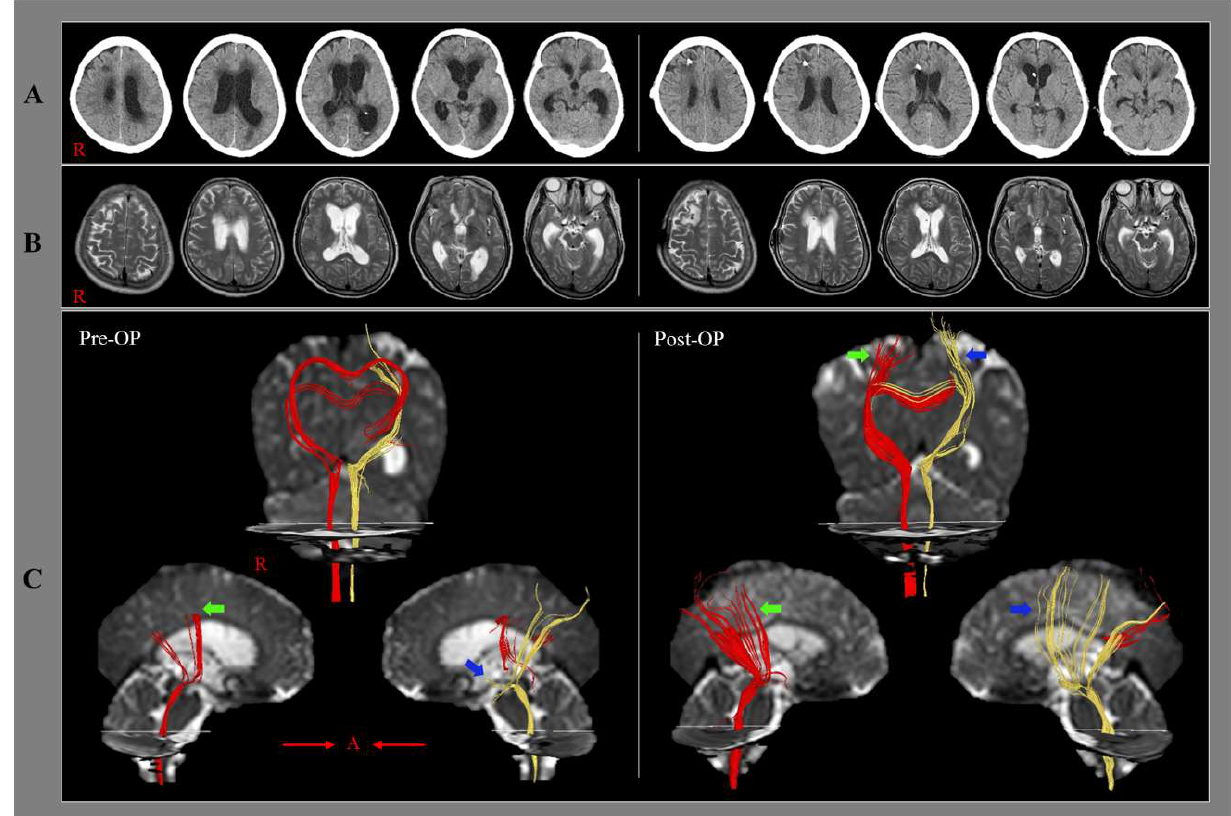
Figure 1. Changes of the corticoreticular pathway following shunt operation. Pre-op brain CT images ( A ) and MR images ( B ) show dilatation of the ventricular system and decrement of dilatation of the ventricular system after shunt operation. Results of diffusion tensor tractography (DTT) for the CRP ( C ). On the pre-op DTT, discontinuations (the right CRP: at subcortical white matter level-green arrow, and the left CRP: at the midbrain level-blue arrow) of the CRP fibers from the premotor cortex were observed in both hemispheres. On the post-op DTT, the CRP fibers were elongated to the respective premotor cortex in both hemispheres (arrows) (reprinted with permission from Medicine (Baltimore):2018;97(4):e9512).